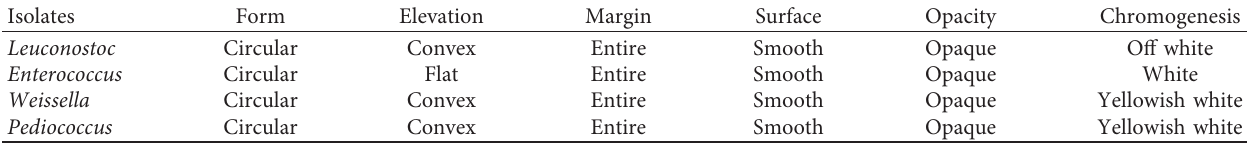
Table 1: Morphological characteristics of colonies of different bacterial isolates.